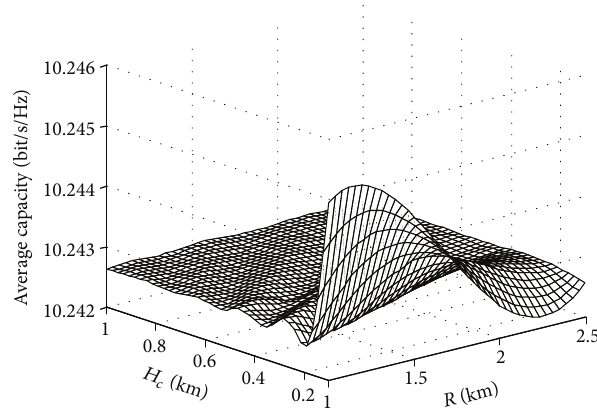
Figure 9: Influences of diffuser parameters on the average channel